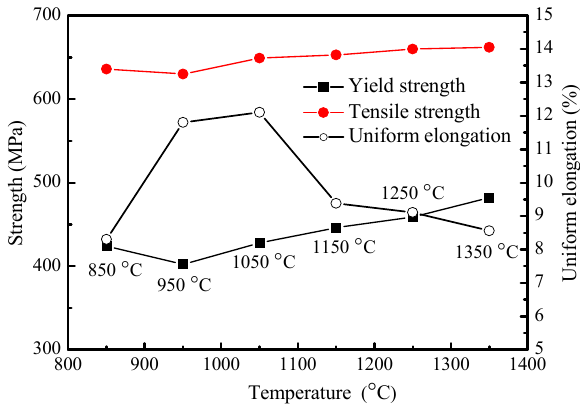
Figure 4. Tensile property under di ff erent peak temperatures. Figure 4. OM images of the simulated welded microstructures ( a ) 1350 °C; ( b ) 1250 °C; ( c ) 1150 °C; ( d ) 1050 °C; ( e ) 950 °C; ( f ) 850 °C.